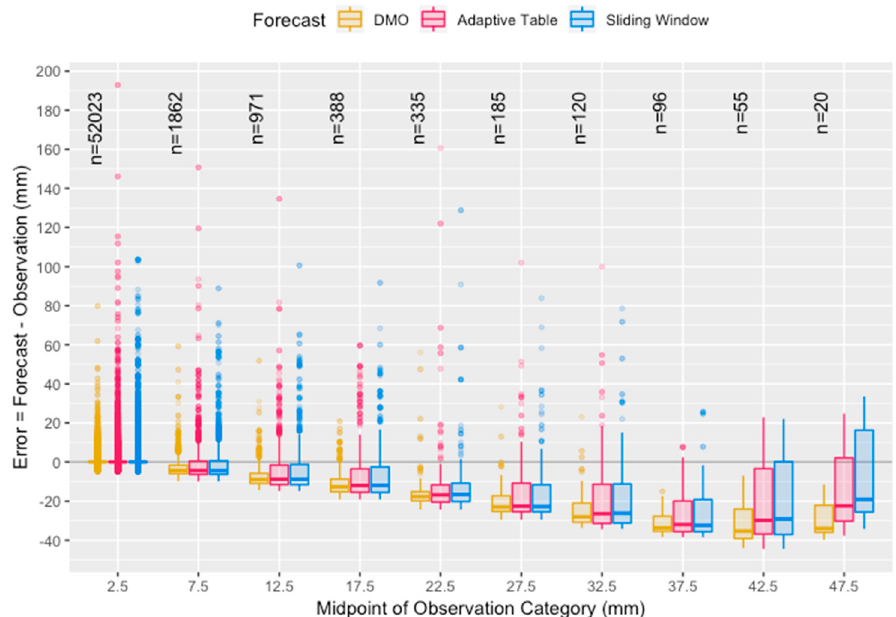
Figure 11. A box-and-whisker plot of the error distribution of the DMO and the two calibrated forecasts against observation categories of 5 mm range up to 50 mm for both ECMWF and JMA. Data with observations over 50 mm are not shown due to the small sample size of extreme events. The thicker horizontal line inside the box represents the median. The boxes enclose data between the first quartile (Q 1 ) and the third quartile (Q 3 ). The whiskers extend from the box to the furthest data within 1.5 times the inter-quartile range (IQR = Q 3 − Q 1 ). The dots represent outliers which are not reached by the boxes and whiskers. The number n states the number of events falling into the corresponding observation category.